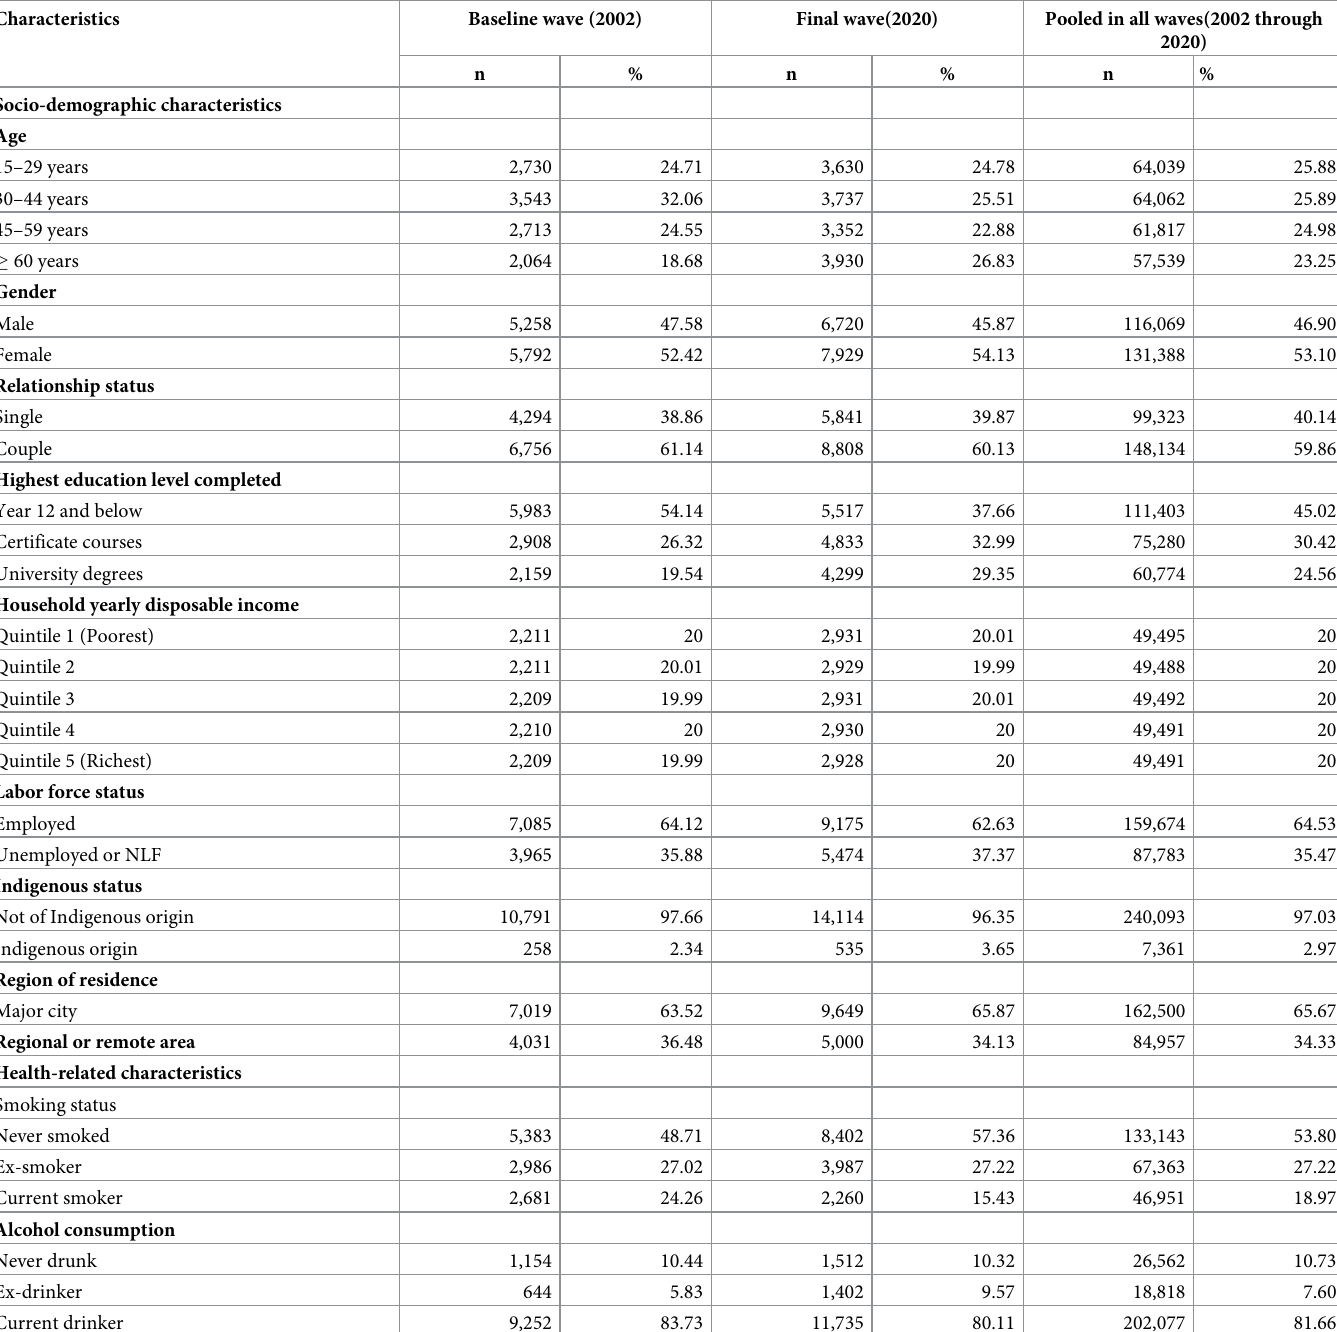
Table 2. Distribution socio-demographic, and health-related characteristics: Baseline, final and pooled across all waves (persons = 29,973; observations = 247,457).